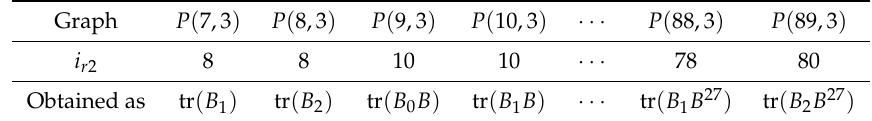
Table 2. i r 2 values for generalized Petersen graphs P ( n ,3 ) .